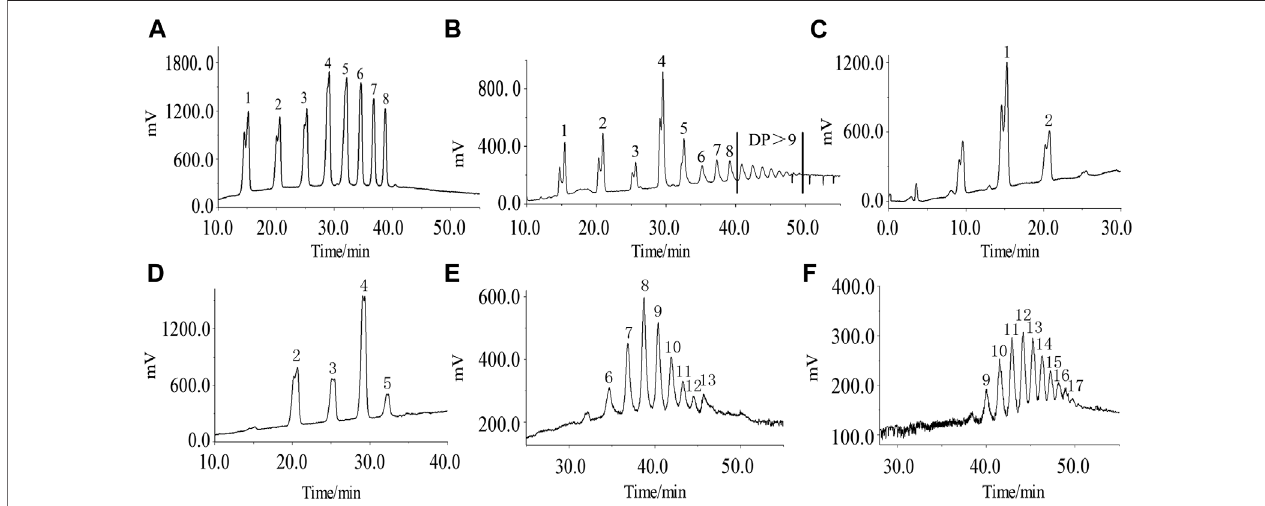
FIGURE1 | HPLC chromatogram ofstandard oligosaccharide samples (A) , APOS (B) , P1 (C) , P2 (D) , P3 (E) , and P4 (F) . 1 – 17:chromatographic peak of dextran with degree of polymerization of 2 – 18.